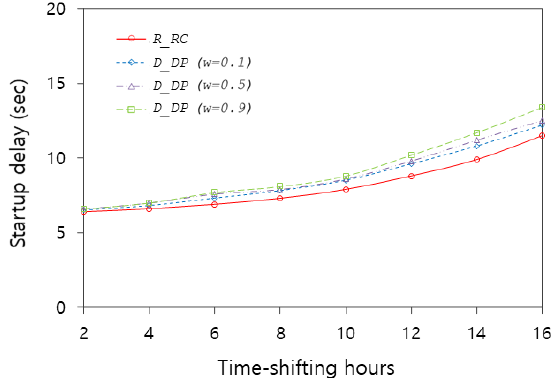
Figure 13. Comparison of startup delay between D _ DP and R _ RP in distribution 2 with 300 s buffer.